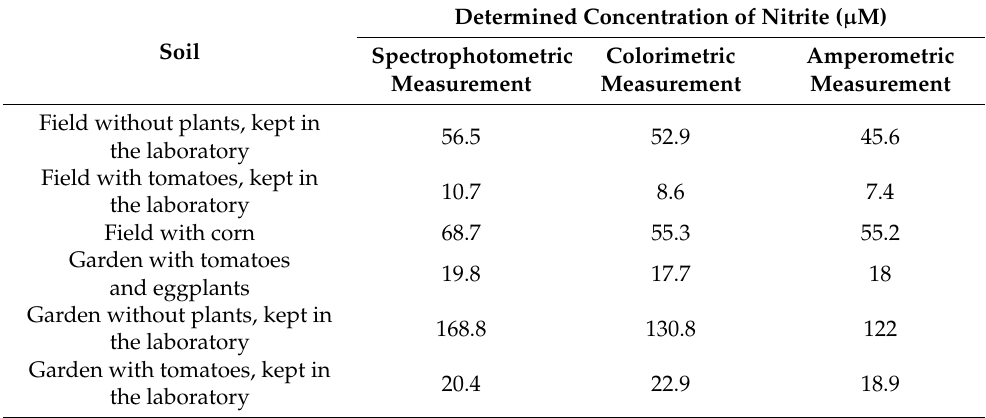
Table 3. Determination of nitrite concentration ( µ M) from various soil solutions using different methods. Determined Concentration of Nitrite ( µ M) Soil Spectrophotometric Colorimetric Amperometric Measurement Measurement Measurement Field without plants, kept in 56.5 the laboratory